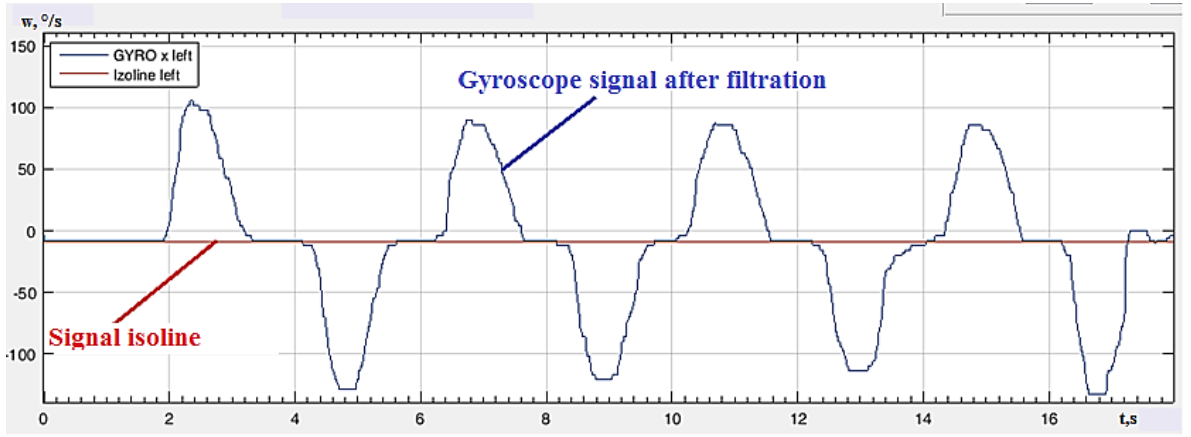
Figure 7 . The detection of gyroscope signal isoline for